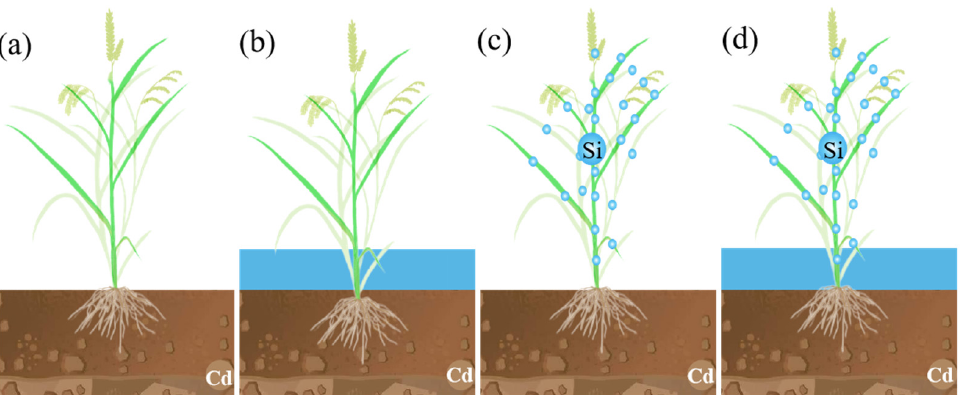
Figure 6. Diagram of the po tt ing experiment (( a ) conventional intermi tt ent fl ooding + no Si foliar spraying (CK); ( b ) continuous flooding throughout the growth stage + no Si foliar spraying (W); spraying (CK); ( b ) continuous fl ooding throughout the growth stage + no Si foliar spraying (W); ( c ) ( c ) conventional intermittent flooding + Si foliar spraying; ( d ) continuous flooding throughout the conventional intermi tt ent fl ooding + Si foliar spraying; ( d ) continuous fl ooding throughout the growth stage + Si foliar spraying growth stage + Si foliar spraying (WSi)).